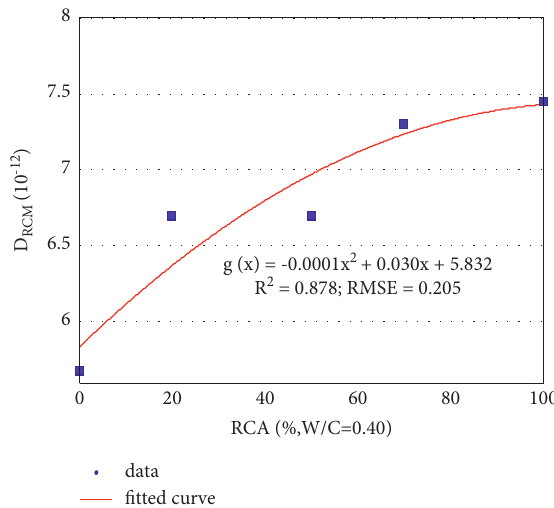
Figure 19: Chloride diffusion coefficient-RCA